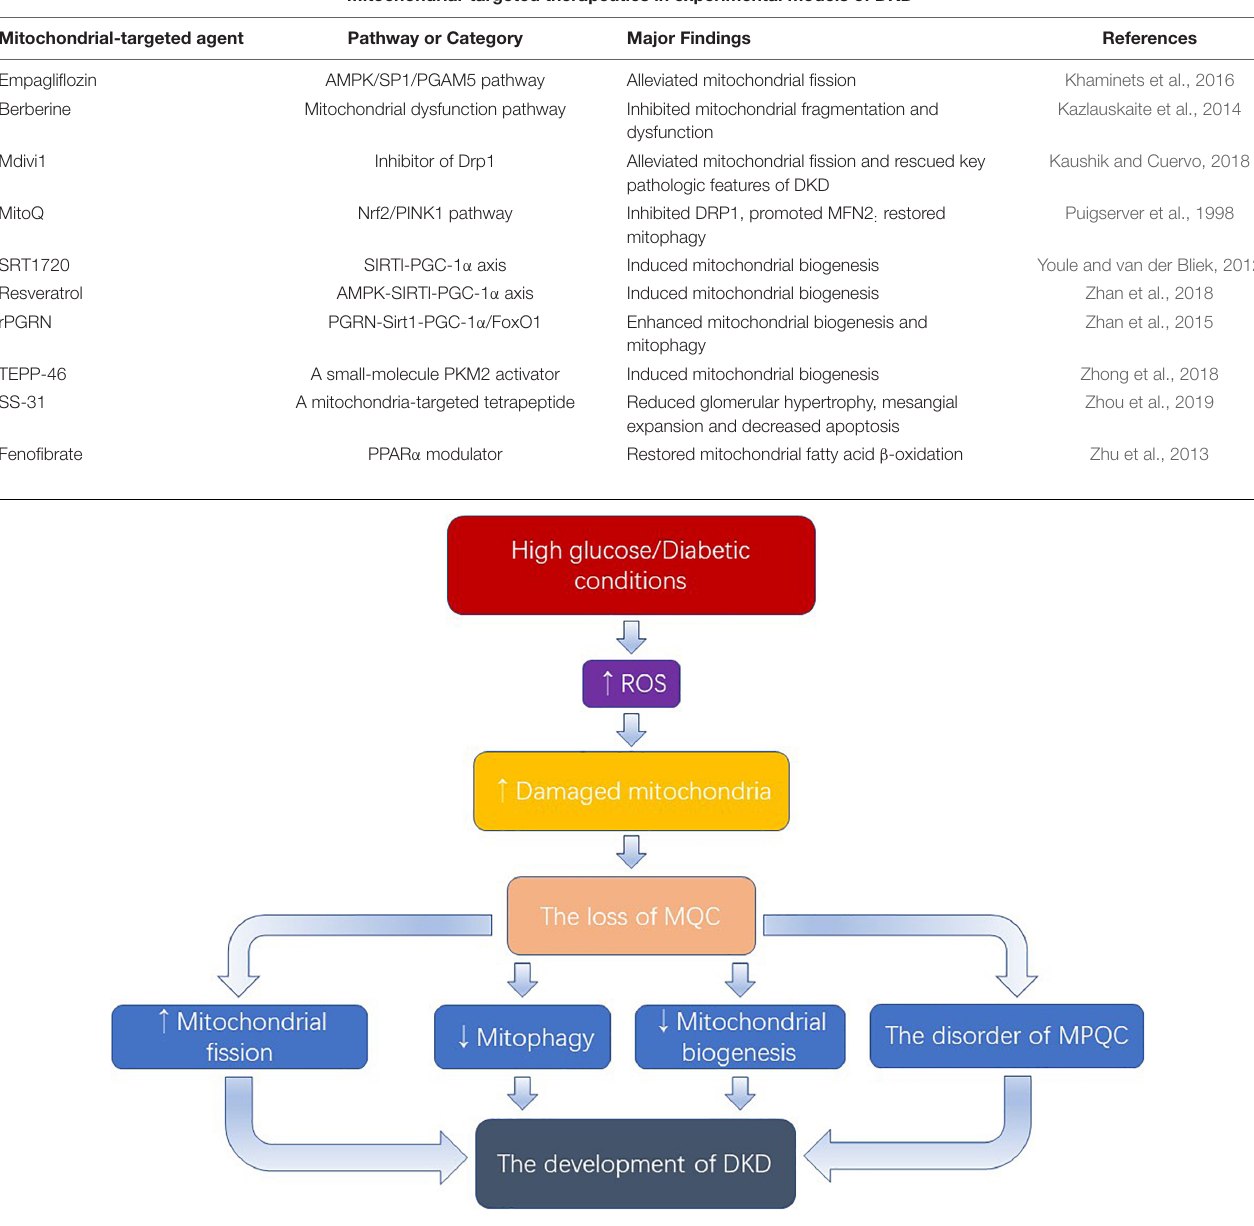
FIGURE 2 | Excess ROS produced by the activation of high glucose causes damage to mitochondria. When the number of damaged mitochondria overwhelms the mitophagy process, the mitochondrial quality control will be damaged. Owning to the rich mitochondrial in the kidney, the loss of MQC exerts an important role in the development of DKD. MQC: mitochondrial quality control; MPQC: mitochondrial protein quality